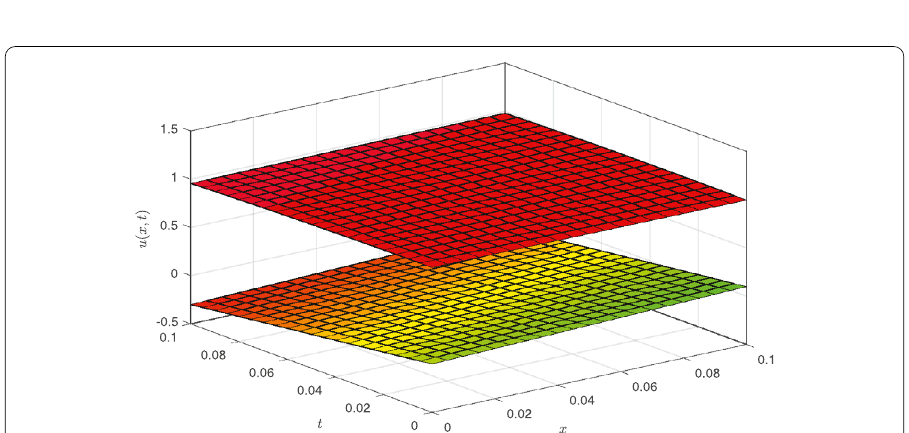
Figure 4 The approximate solution of Example 1 for Case 2 and α = β = 1